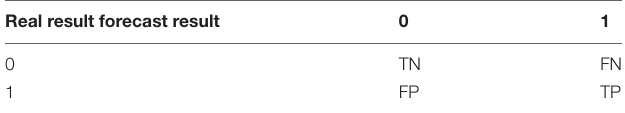
TABLE 1 | Logistic model prediction